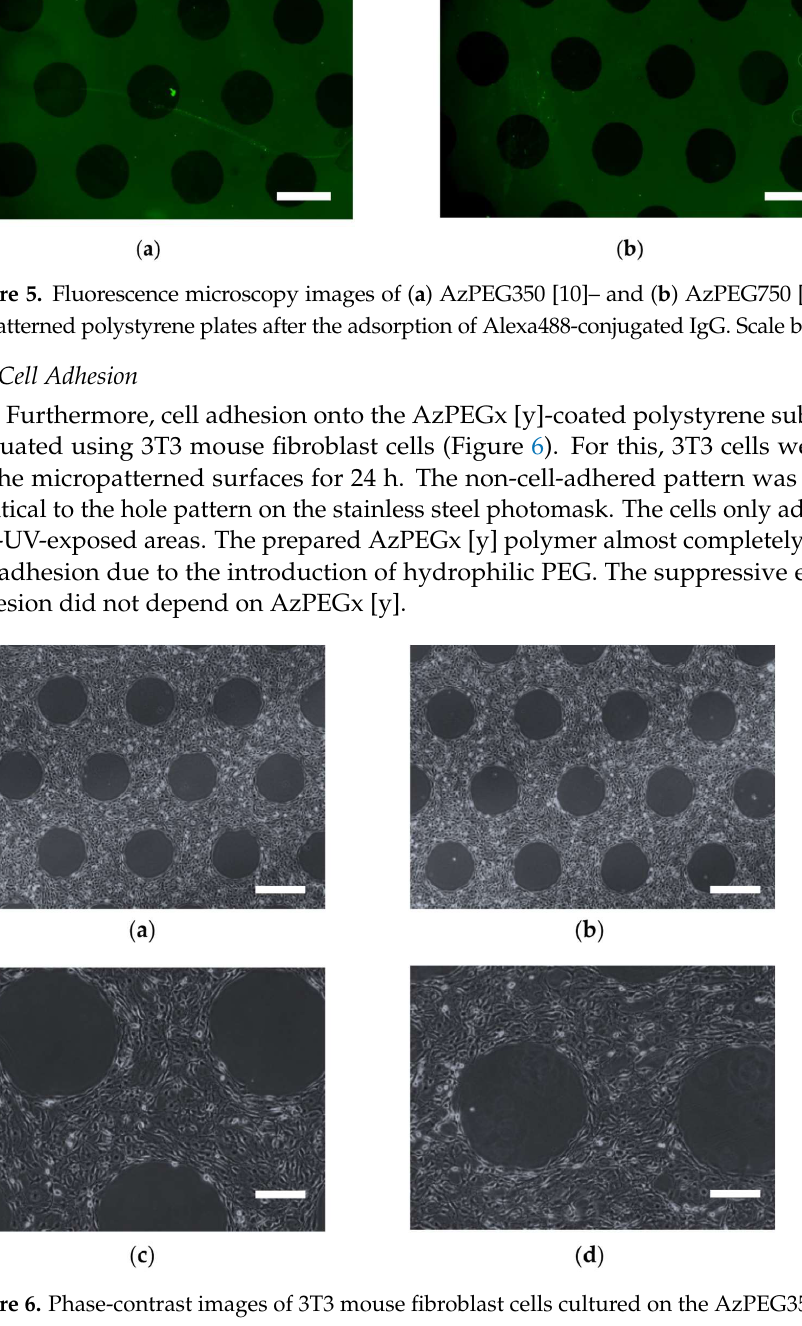
Figure 6. Phase-contrast images of 3T3 mouse fibroblast cells cultured on the AzPEG 350 [10]-coated ( a , c ) and AzPEG 750 [5]-coated ( b , d ) micropatterned polystyrene plates at 0.25 wt.%. Scale bars: ( a , b ) µ m; ( c , d ) 200 µ 500 µm; ( c , d ) 200 µm. ( a , b ) 500